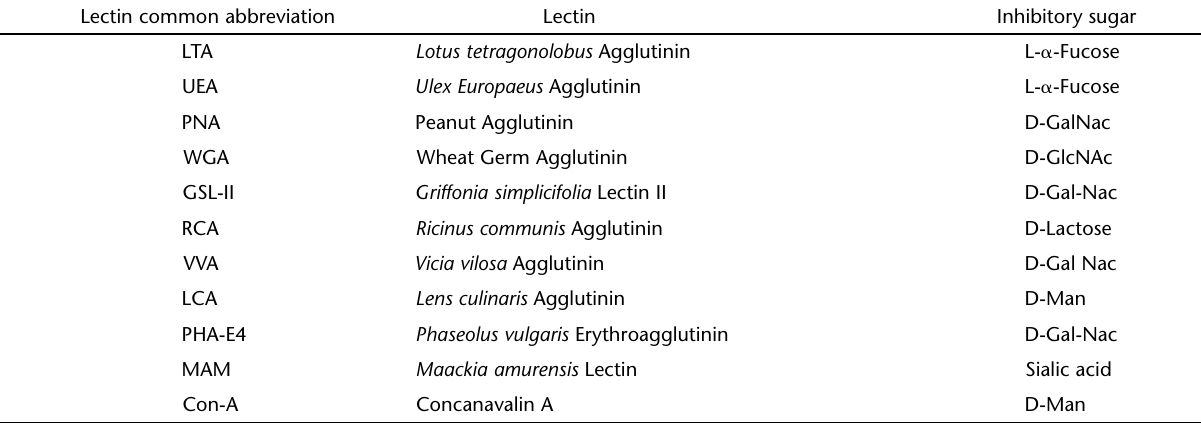
Table I. Biotinilated lectins and their respective inhibitory sugars. Lectin common